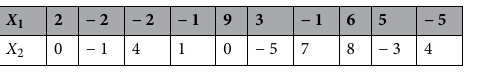
Table 1. Initial conditions of the states of the agents.